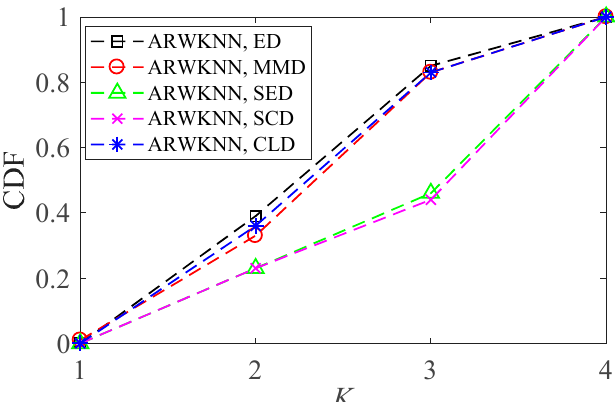
Figure 22. In 2-D, the cumulative distributions of the optimal K with K max = 4.